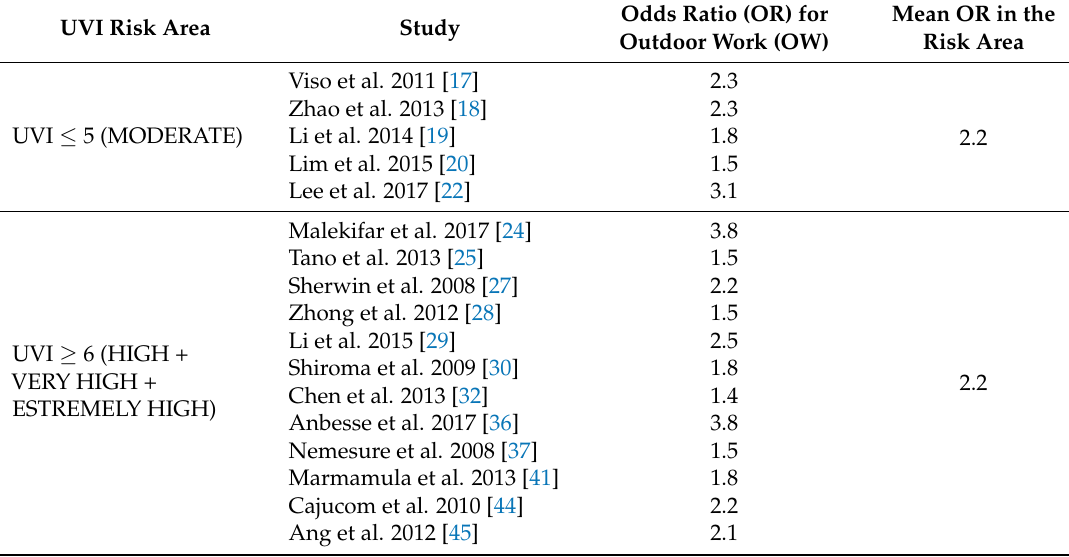
Table 7. Mean Odds Ratios for likelihood of Outdoor Workers to have pterygium in the studies reviewed according to the UV risk areas: evaluation of the differences. UVI Risk Area Study